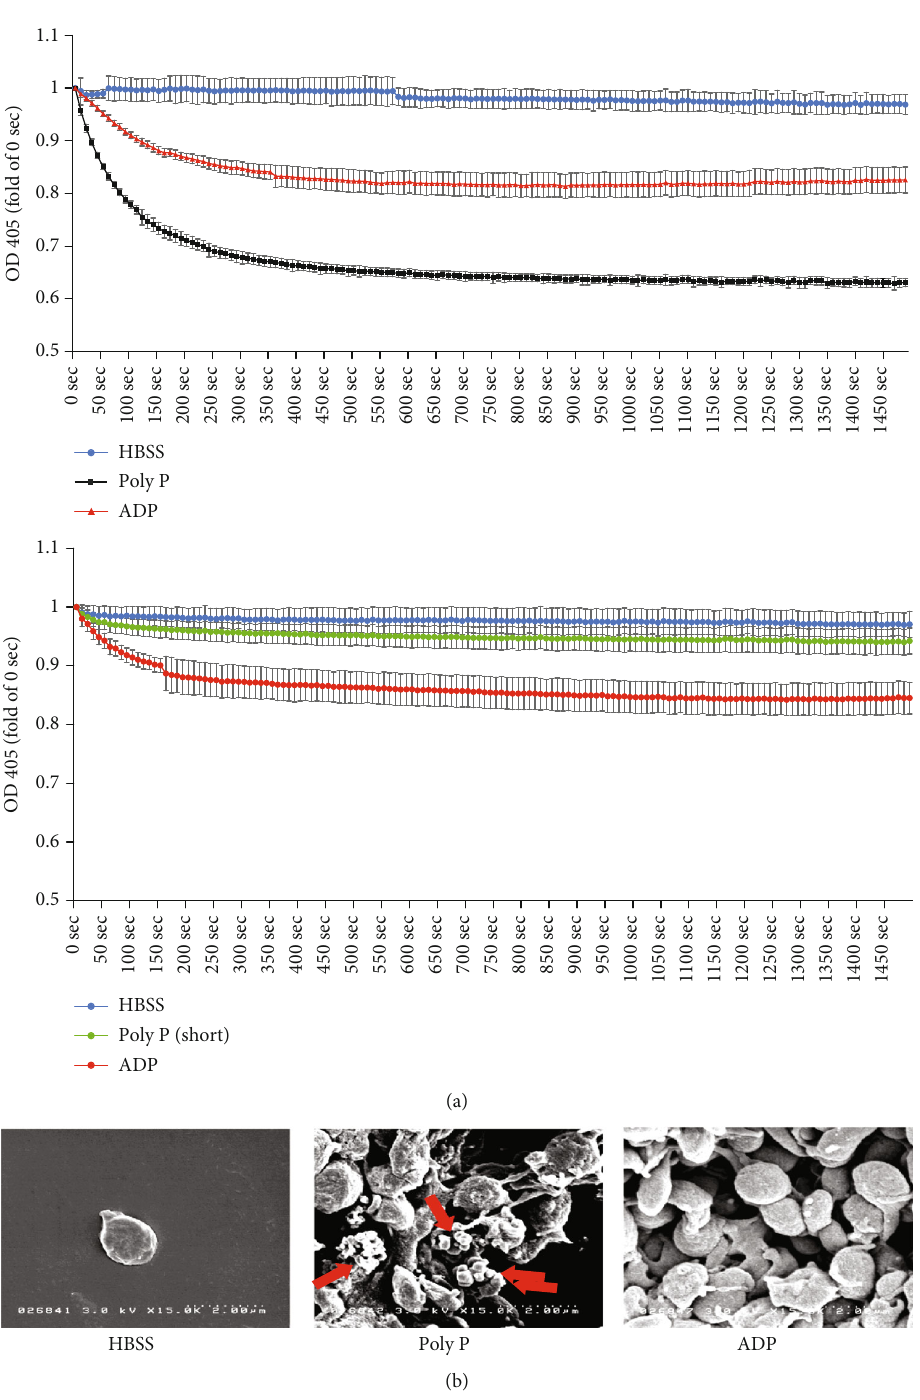
Figure 2: Poly P induced platelet aggregation. A platelet aggregation assay showed that long-chain poly P as well as short-chain poly P induced platelet aggregation and the e ff ect of long-chain poly P on platelet aggregation was stronger than that of ADP (a). An SEM analysis indicated the morphological changes in naïve platelets by treatment with poly P or ADP (b). The arrow shows the insoluble particles, suspected of being poly P nanoparticles. The error bars and numbers show the standard